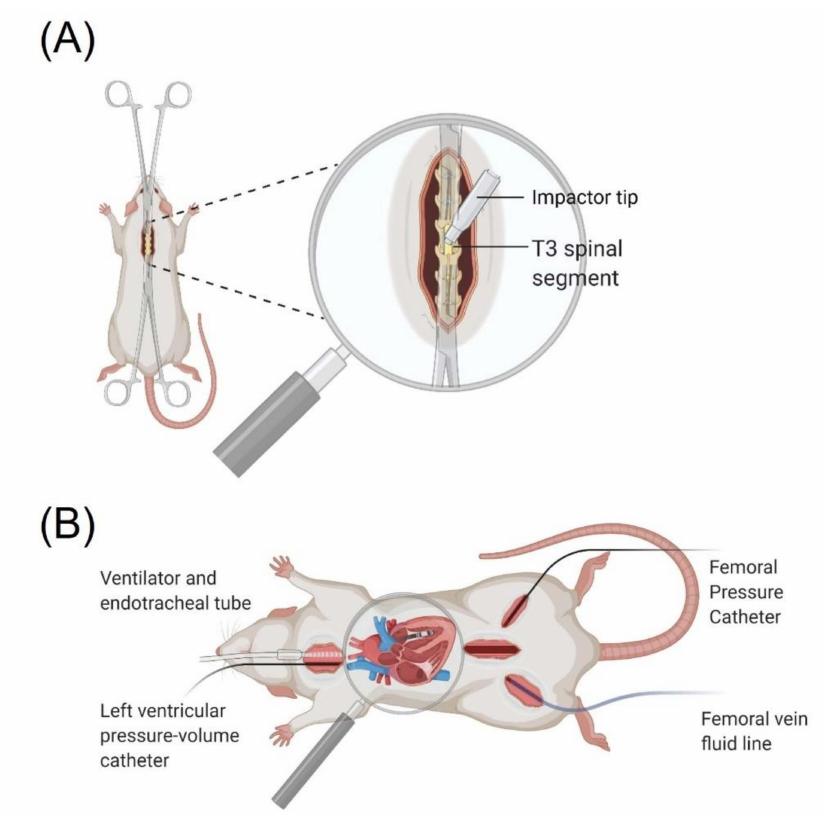
Figure 1. ( A ) Rodent SCI surgery setup depicting laminectomy and contusion injury method. ( B ) In vivo terminal preparation consisting of an endotracheal tube and ventilator, left ventricular pressure-volume catheter, femoral artery pressure catheter, and femoral venous